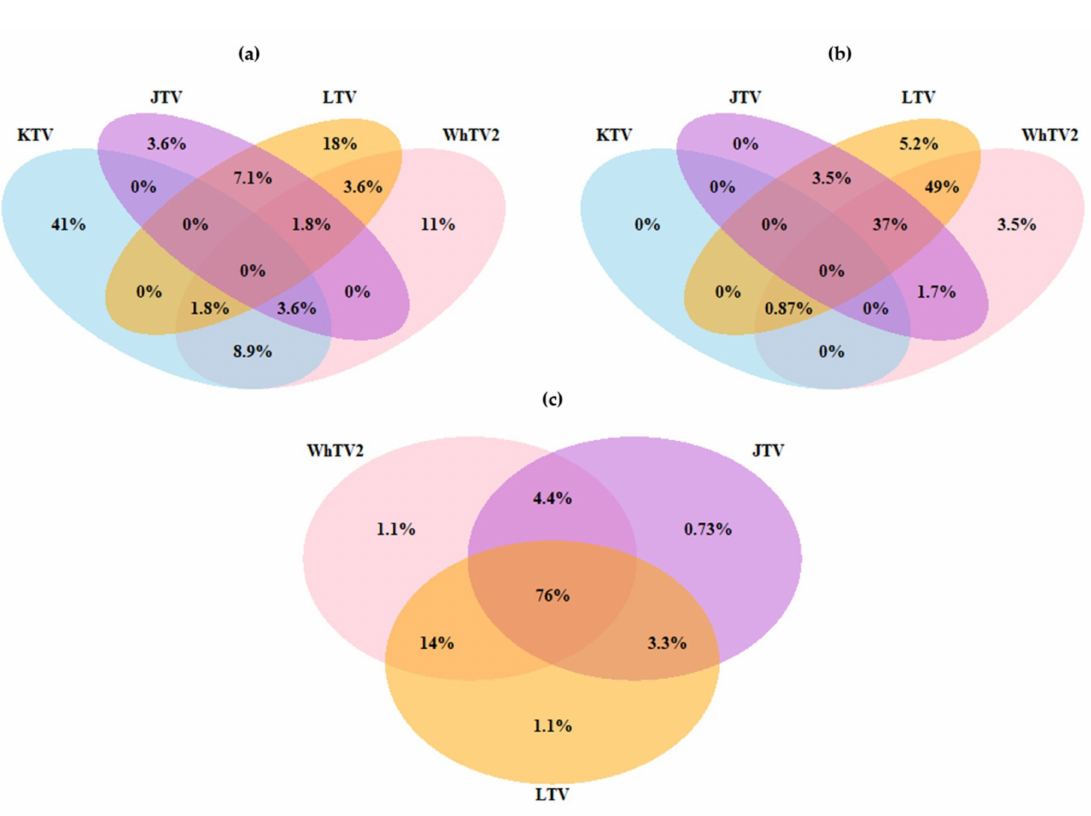
Figure 5. Virus co-infections in Carribean ticks. ( a ) Percentage of viral co-infections in positive Amblyomma variegatum samples collected in Guadeloupe (out of 56 positive samples) ( b ) Percentage of viral co-infections in positive Rhipicephalus microplus samples collected in Guadeloupe (out of 115 positive samples) and ( c ) Percentage of viral co-infections in positive Rhipicephalus microplus samples collected in Martinique (out of 274 positive samples). KTV: Karukera tick virus; WhTV2: Wuhan tick virus 2; JTV: Jingmen tick virus; LTV: Lihan tick